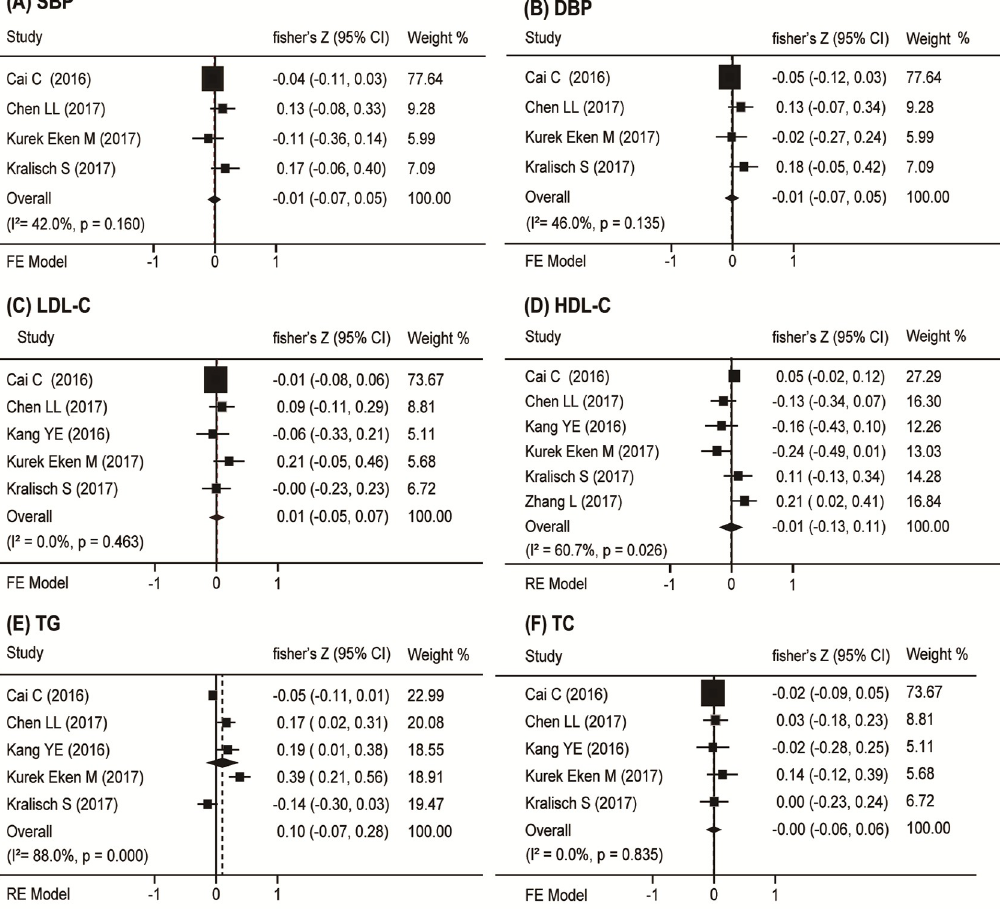
Fig 5. Forest plot of the association between circulation Nrg4 levels and metabolic syndrome markers in DM. Summaries are shown of the association circulation Nrg4 levels and (A) SBP, (B) DBP, (C) LDL-C, (D) HDL-C, (E) TG, (F) TC.